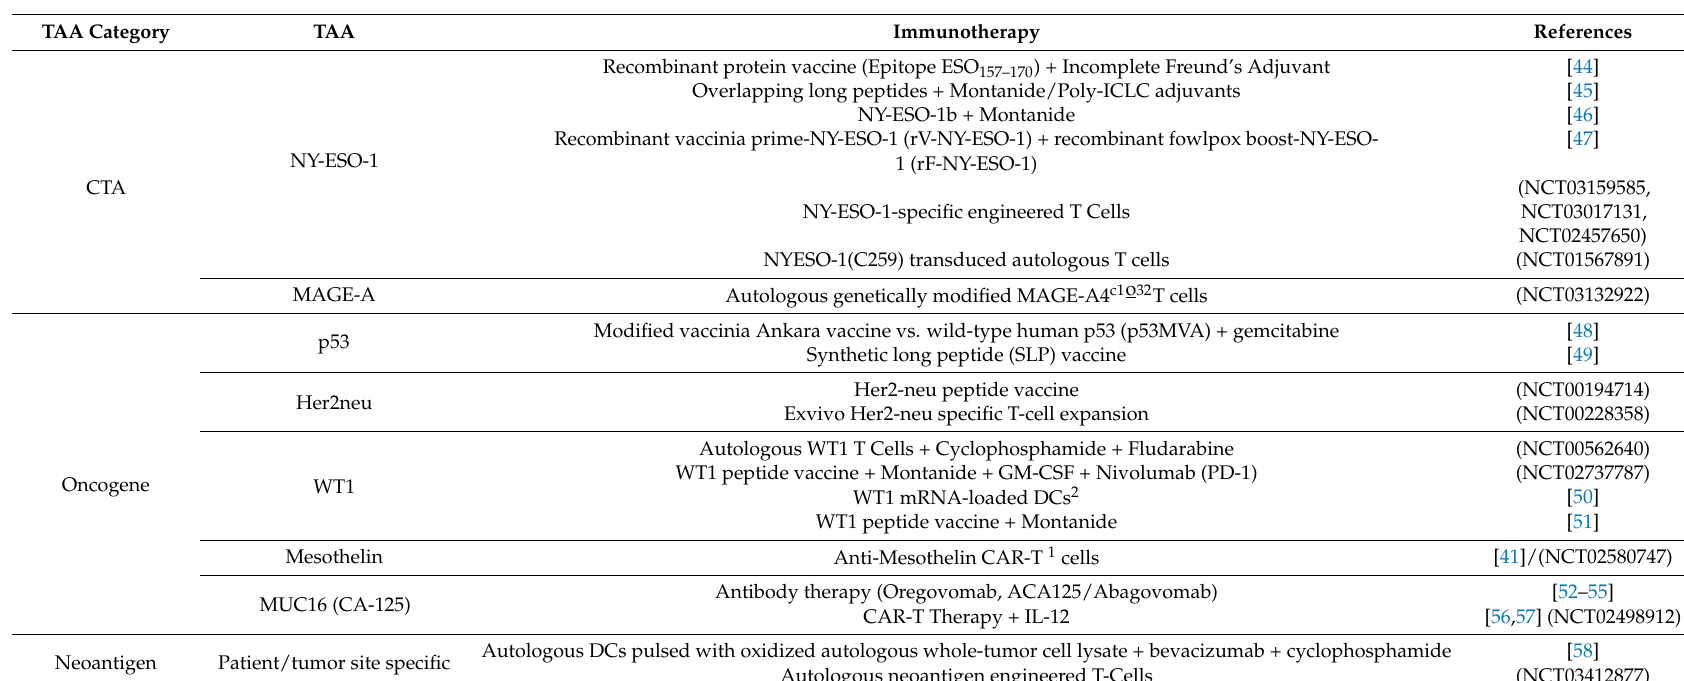
Table 3. TAA targeted immunotherapies in